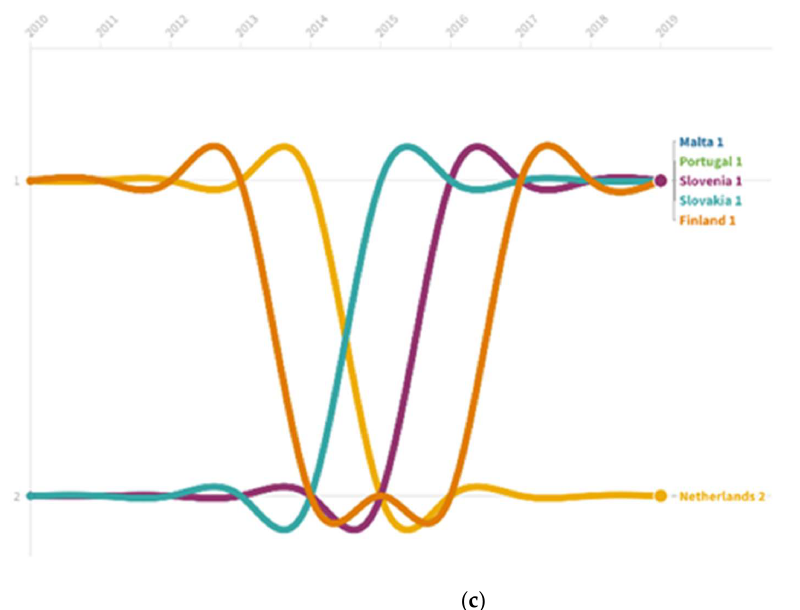
Figure 3. ( a – c ) The detailed timeline of clusters for the two-cluster and 18 countries cases. Source Authors’ construction.